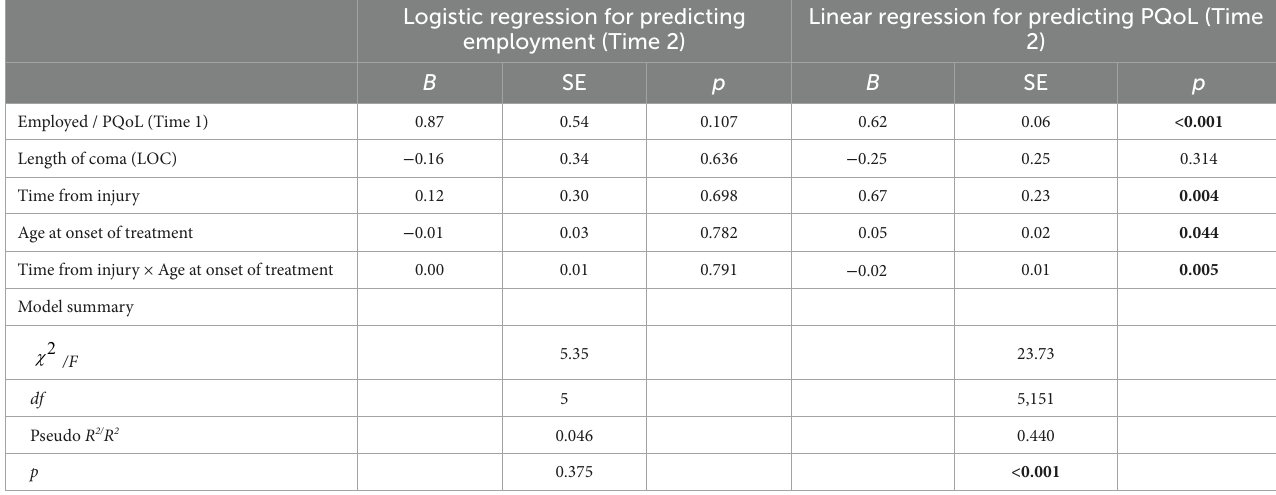
TABLE 3 Regression models for predicting employment and perceived quality of life (PQoL) after rehabilitation. Logistic regression for predicting employment (Time 2)